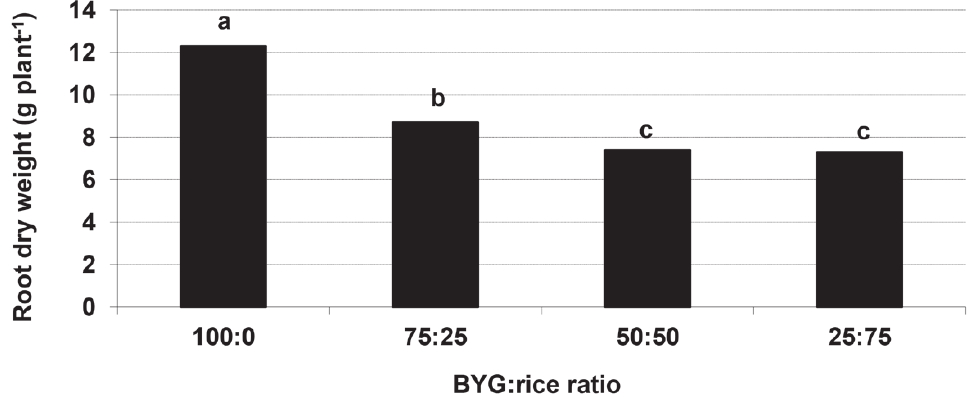
Figure 4 - Effect of barnyardgrass (BYG):rice ratio on root dry weight of